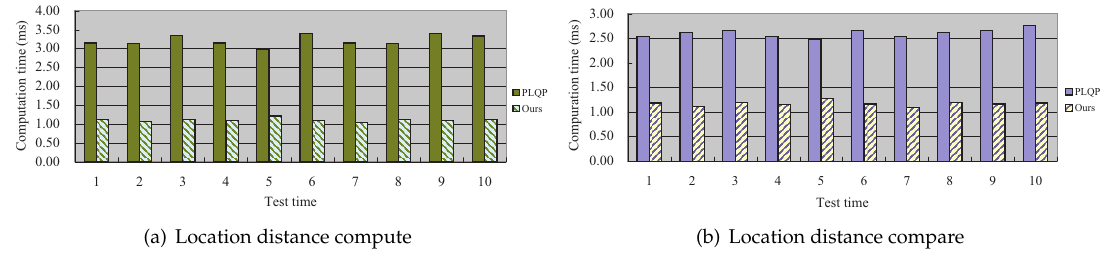
Figure 6. The comparison of the total time cost between our scheme and PLQP.